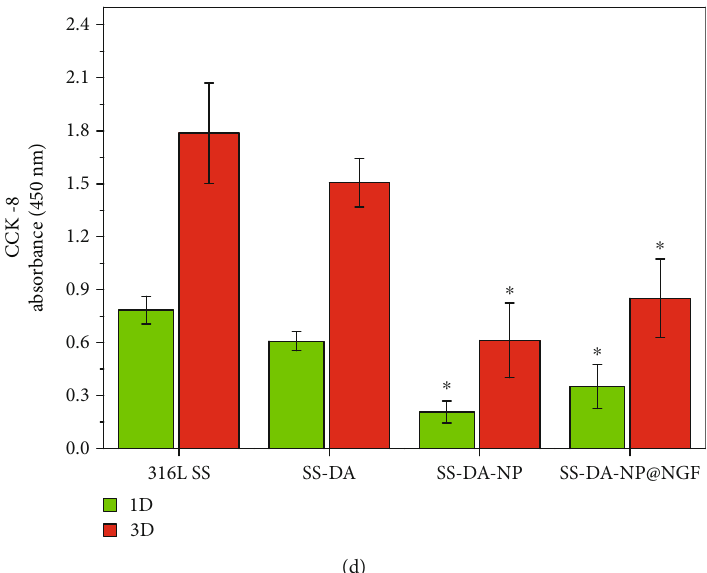
Figure 5: Rhodamine 123 and DAPI fl uorescence staining of adhered (a) ECs and (c) SMCs after culture of 1 day and 3 days. The proliferation activity of (b) ECs and (d) SMCs was detected by CCK-8 assay ( mean ± SD , n = 6 , ∗ p < 0 : 05 indicates signi fi cant di ff erence compared to 316L SS and